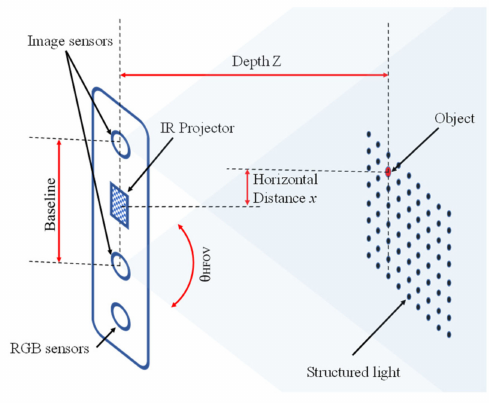
Figure 2. Principle of active infrared stereo vision